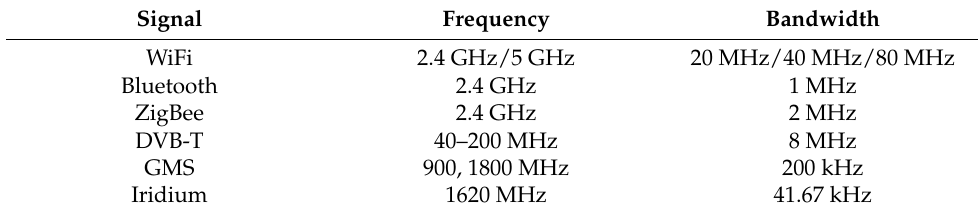
Table 1. List of common